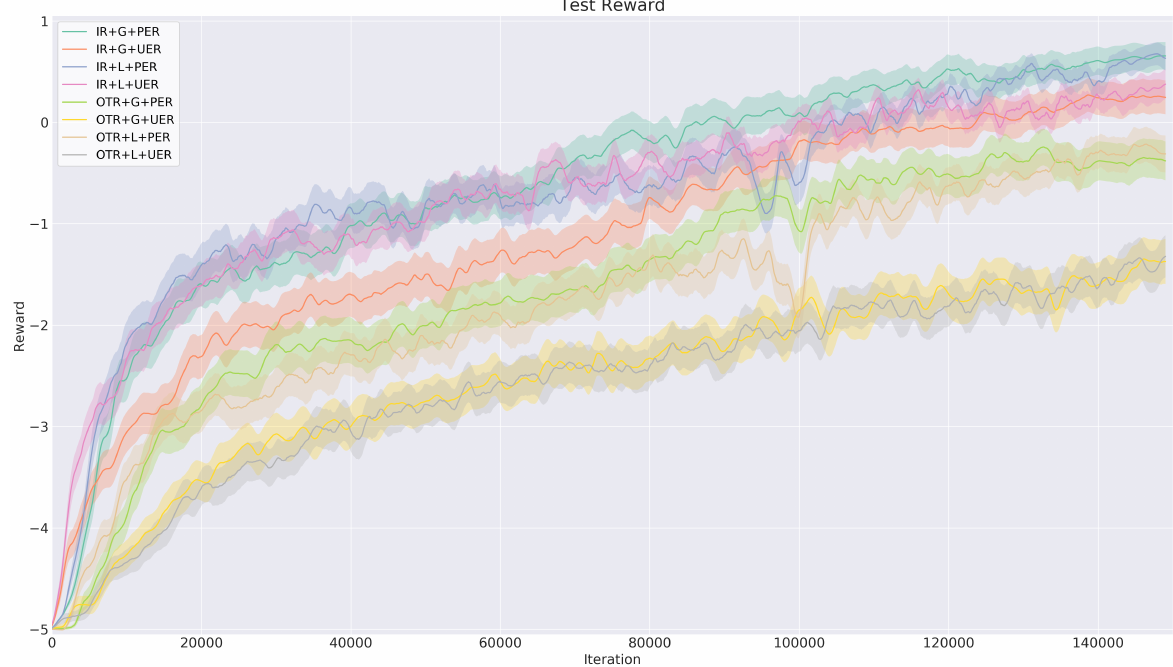
Figure 7: The collected reward by the RL agent during the test episodes. The agent performs best when it receives the intermediate reward with prioritized experience replay. The curves are smoothed with a moving average with a sliding window of 1000 iterations. The confidence interval shows the standard error and each curve is the average of 160 experiments (16 RL agents × 10